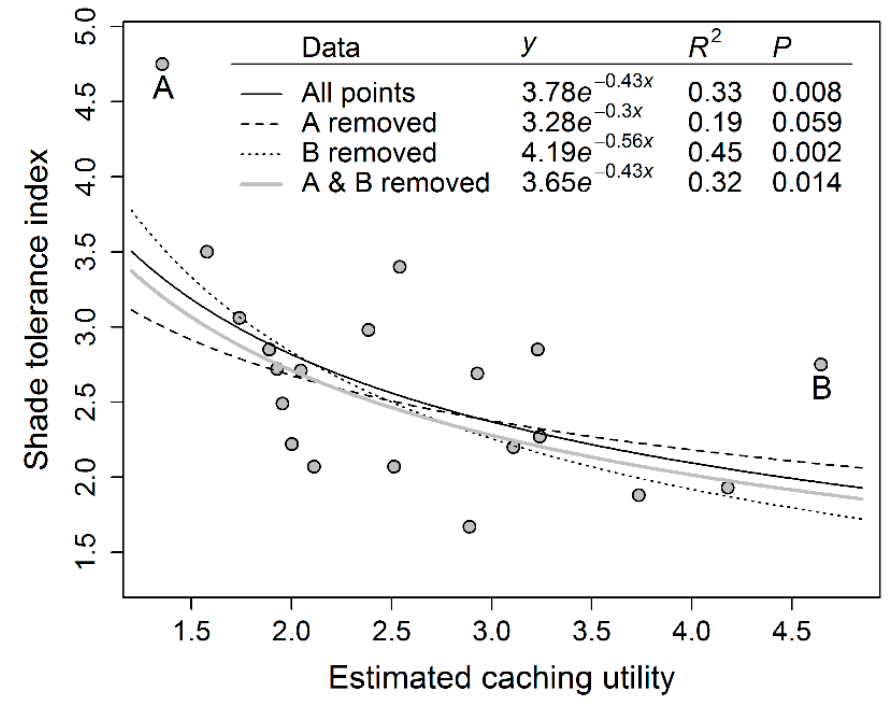
Figure 4. Shade tolerance is inversely related to the caching-utility of scatter-hoarded seeds. Caching data come from [72,73] and shade tolerance data from [74]. Two data points, labeled A and B on the figure, are potential high-influence points. We therefore account for statistical relationships with and without these outliers.